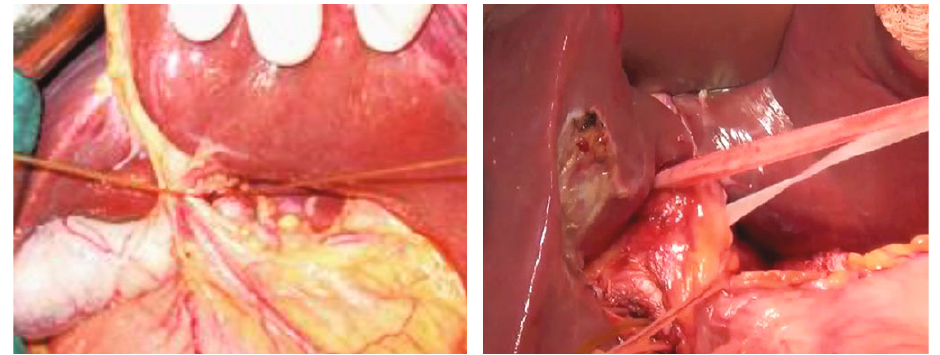
Figure 4: Intrafascial and extrafascial left Glissonean pedicle approach.